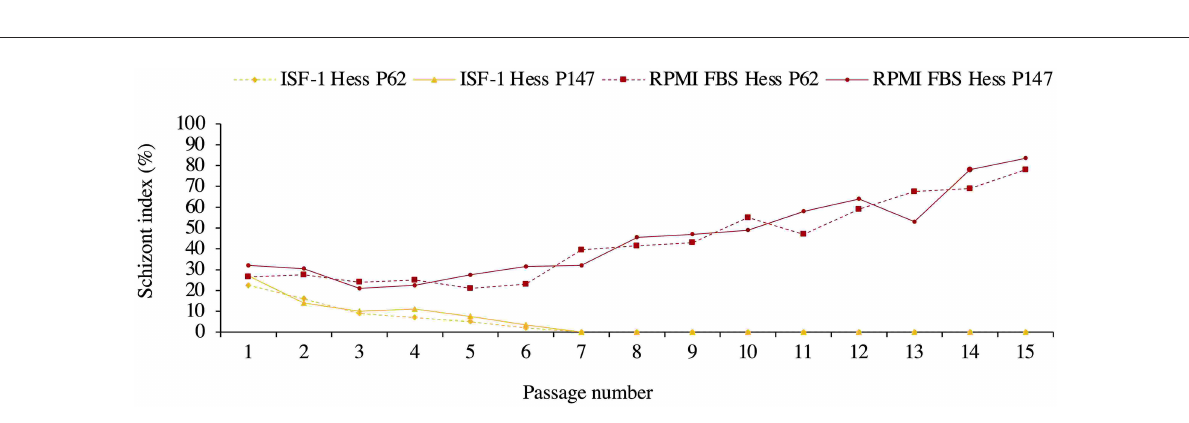
RPMI-FBS (mean = 96.1% ± 1.5) than in ISF-1 (80.5% ±